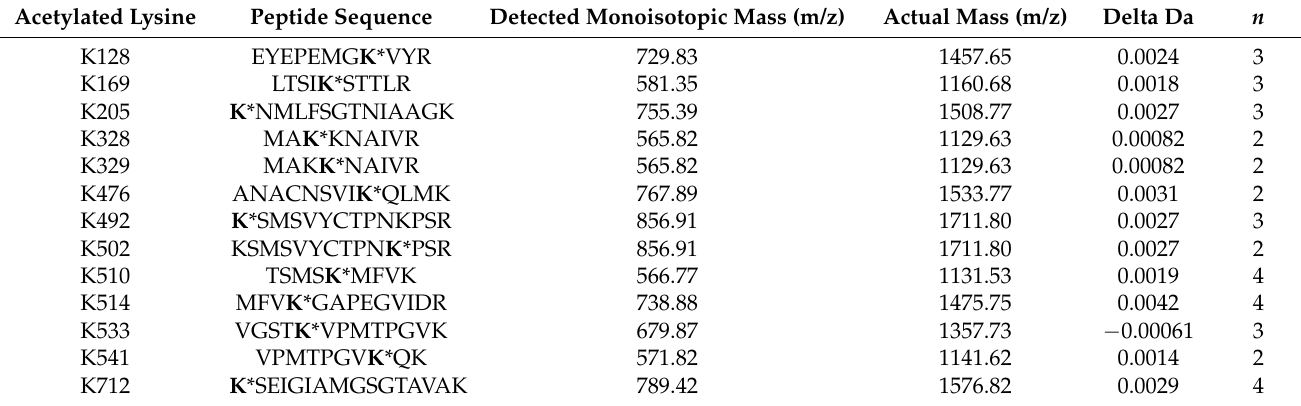
Table 1. Summary of acetylation sites in SERCA2a identified by mass spectrometry